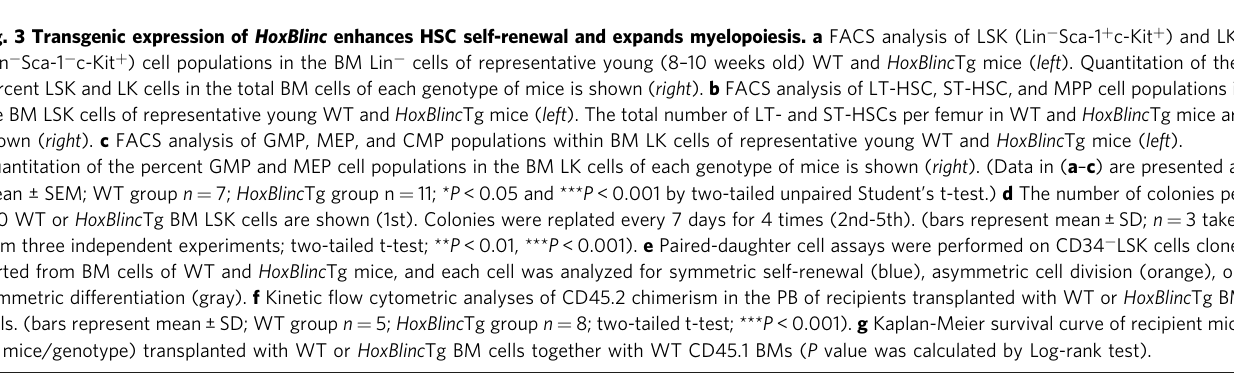
Fig. 3 Transgenic expression of HoxBlinc enhances HSC self-renewal and expands myelopoiesis. a FACS analysis of LSK (Lin − Sca-1 + c-Kit + ) and LK (Lin − Sca-1 − c-Kit + ) cell populations in the BM Lin − cells of representative young (8 – 10 weeks old) WT and HoxBlinc Tg mice ( left ). Quantitation of the percent LSK and LK cells in the total BM cells of each genotype of mice is shown ( right ). b FACS analysis of LT-HSC, ST-HSC, and MPP cell populations in the BM LSK cells of representative young WT and HoxBlinc Tg mice ( left ). The total number of LT- and ST-HSCs per femur in WT and HoxBlinc Tg mice are shown ( right ). c FACS analysis of GMP, MEP, and CMP populations within BM LK cells of representative young WT and HoxBlinc Tg mice ( left ). Quantitation of the percent GMP and MEP cell populations in the BM LK cells of each genotype of mice is shown ( right ). (Data in ( a – c ) are presented as mean ± SEM; WT group n = 7; HoxBlinc Tg group n = 11; * P < 0.05 and *** P < 0.001 by two-tailed unpaired Student ’ s t-test.) d The number of colonies per 100 WT or HoxBlinc Tg BM LSK cells are shown (1st). Colonies were replated every 7 days for 4 times (2nd-5th). (bars represent mean ± SD; n = 3 taken from three independent experiments; two-tailed t-test; ** P < 0.01, *** P < 0.001). e Paired-daughter cell assays were performed on CD34 − LSK cells clone- sorted from BM cells of WT and HoxBlinc Tg mice, and each cell was analyzed for symmetric self-renewal (blue), asymmetric cell division (orange), or symmetric differentiation (gray). f Kinetic fl ow cytometric analyses of CD45.2 chimerism in the PB of recipients transplanted with WT or HoxBlinc Tg BM cells. (bars represent mean ± SD; WT group n = 5; HoxBlinc Tg group n = 8; two-tailed t-test; *** P < 0.001). g Kaplan-Meier survival curve of recipient mice (8 mice/genotype) transplanted with WT or HoxBlinc Tg BM cells together with WT CD45.1 BMs ( P value was calculated by Log-rank